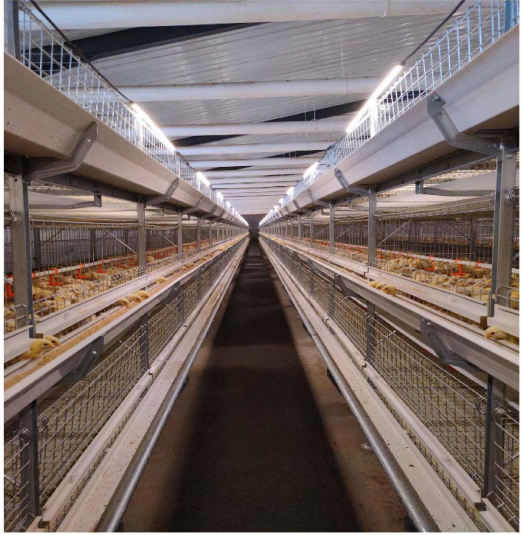
Figure 1. Structure of broiler house and waterline